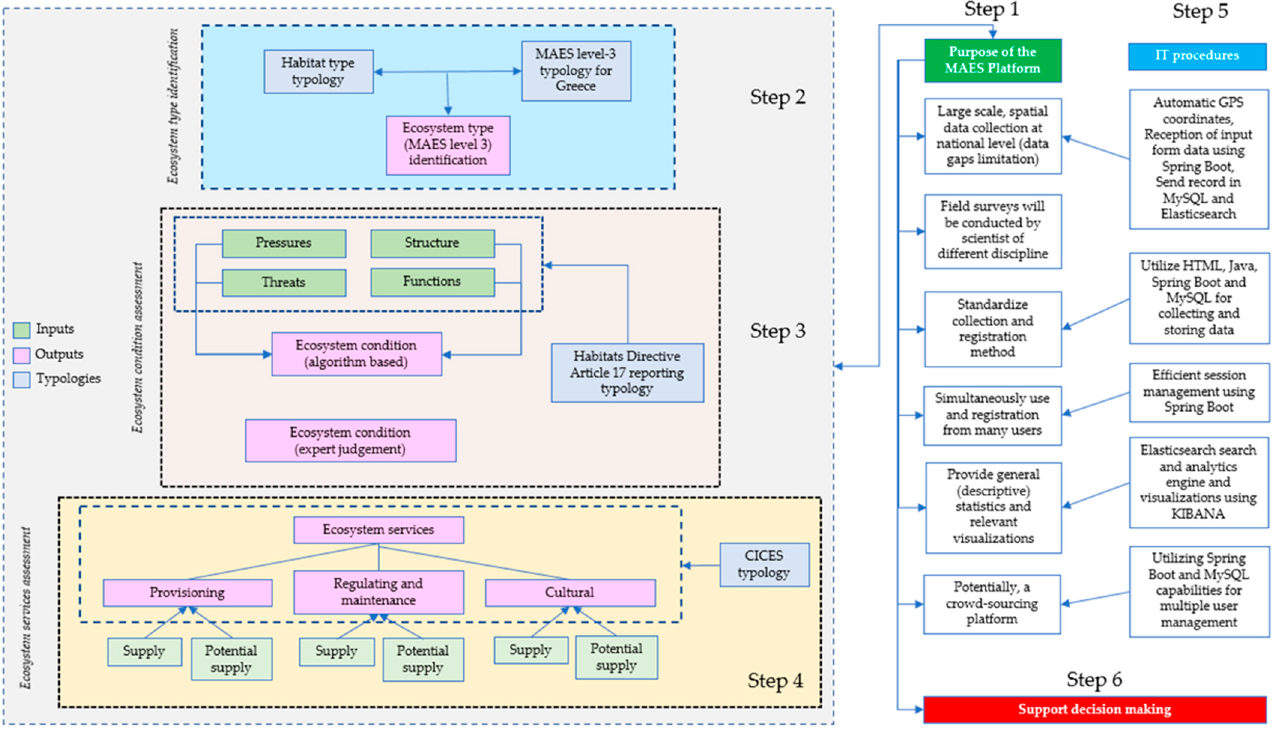
Figure 1. Methodological flow-chart for the platform development.